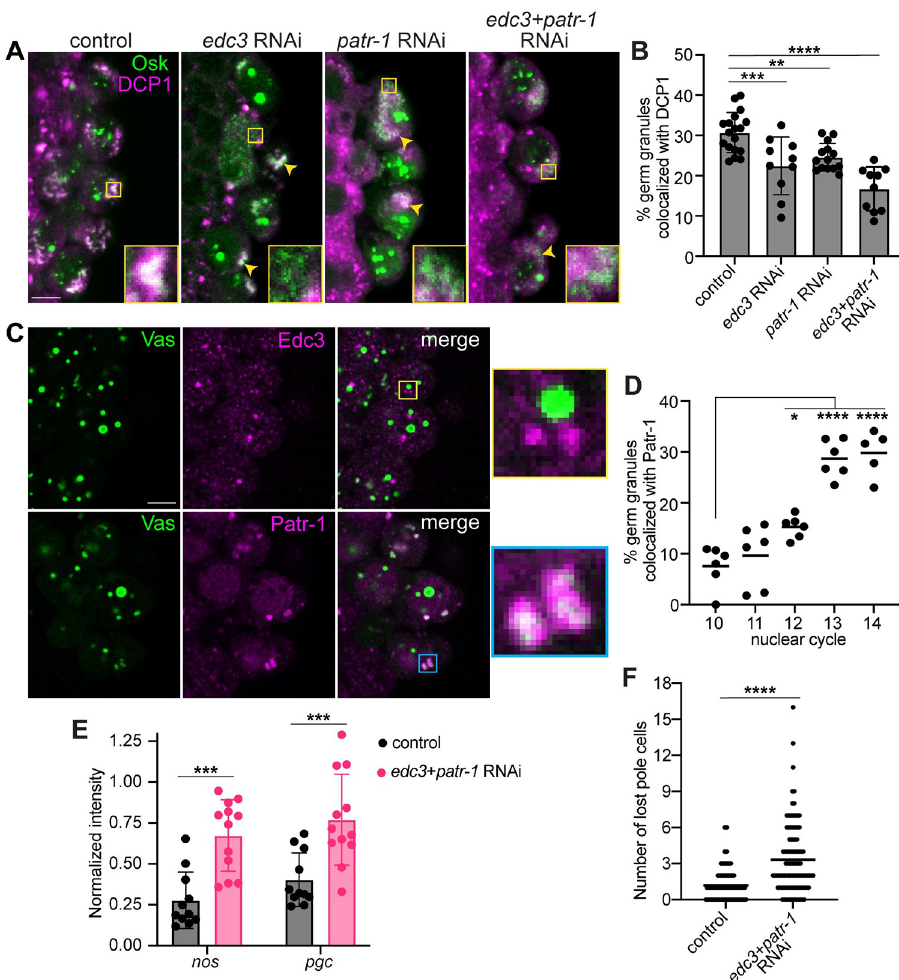
Fig 6. Edc3 and Patr-1 promote recruitment of the decapping complex to germ granules. (A) Single confocal sections of pole cells in nc13-14 mat α -GAL4 only, edc3 RNAi, patr-1 RNAi, and edc3 and patr-1 double RNAi embryos expressing an osk-sfgfp transgene. Osk-sfGFP was detected by direct fluorescence (green) together with anti-DCP1 immunofluorescence (magenta). Enlargements of the boxed regions show germ granules that recruit DCP1 in control embryos and granules that fail to recruit DCP1 in RNAi embryos. Yellow arrows indicate germ granules in the RNAi embryos that recruit DCP1. (B) Quantification of the percent of cytoplasmic Osk-GFP puncta that colocalize with DCP1 in control and RNAi embryos. Genotypes were compared by Ordinary one-way ANOVA and Dunnett’s multiple comparison test, n = 10–18 embryos per genotype. (C) Single confocal sections of the pole cells at nc14 in embryos expressing Vas-GFP (green). Vas-GFP (green) was detected by direct fluorescence and Edc3 and Patr-1 (magenta) were detected immunofluorescence. Enlargements of the boxed regions show Patr-1 (cyan box), but not Edc3 (yellow box) puncta, overlap with germ granules. (D) The percent of germ granules, marked by cytoplasmic Vas- GFP, that colocalize with Patr-1 was quantified from nc10 to nc14. Nuclear cycles were compared by Ordinary one- way ANOVA and Dunnett’s multiple comparison test, n = 5–6 embryos per nuclear cycle. Nuclear puncta of Osk (B) or Vas (D) were masked using Imaris software. (E) The proportion of nos and pgc remaining in the pole cells at nc14 was quantified in control and double RNAi embryos. nos and pgc were detected by smFISH and their total intensities at nc14 were normalized to their average intensities during nc9-13. Genotypes were compared by Mann–Whitney test, n = 11–12 embryos. (F) Pole cells were detected by Vas immunohistochemistry in control and double RNAi embryos. The lost pole cells at Bownes stages 13 and later were counted, n = 103–106 embryos per genotype. Genotypes were compared by Mann–Whitney test. Individual data points and mean values (D, F) or mean ± SD (B, E) are shown; * p < 0.05, ** p < 0.01, *** p < 0.001, **** p < 0.0001. Source data for the graphs Fig 6B and 6D–6F are provided in S1 Data. Scale bars: 5 μ m. smFISH, single-molecule fluorescence in situ